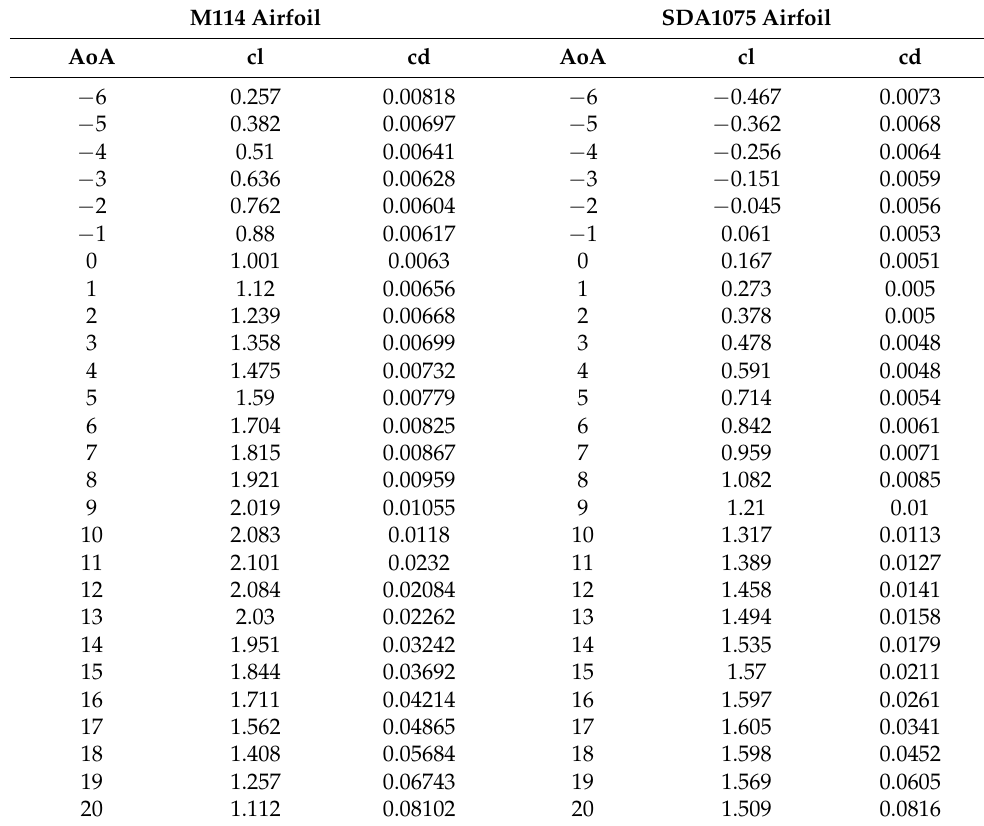
Figure 9. DEP propeller designed with Patterson’s approach. ( a ) Chord distribution. ( b ) Pitch angle distribution. Table 7. Aerodynamic data of M114 and SDA1075 blade airfoil, XFOIL M = 0.15, Re = 3 × 10 6 .